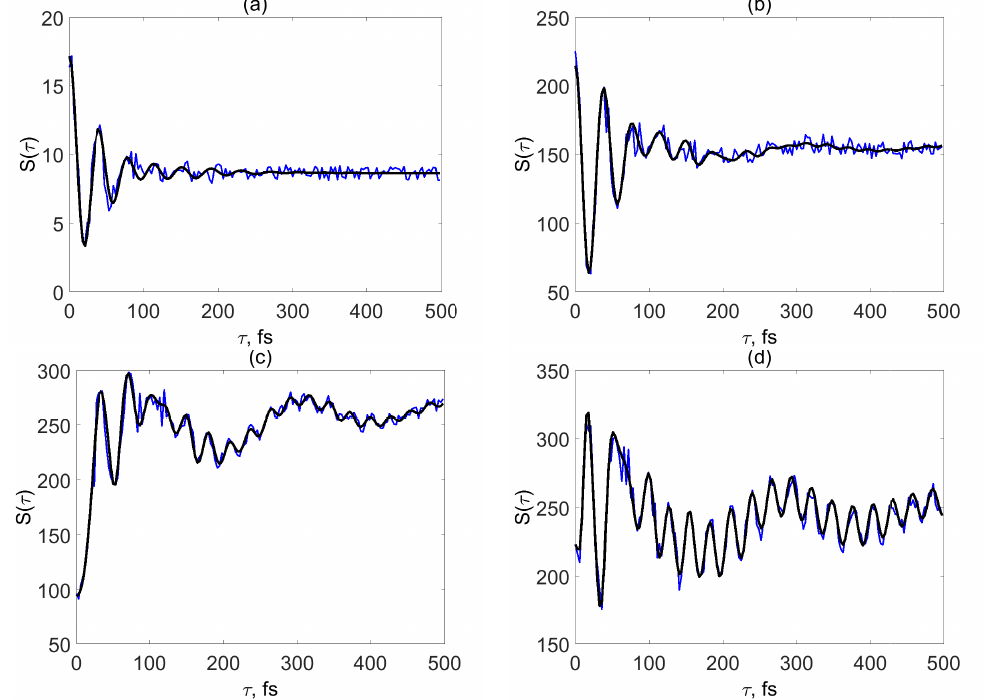
Figure 2. Model I. SM signals for different system-field couplings. η 02 = 0.01 eV ( a ), 0.05 eV ( b ), 0.11 eV ( c ), and 0.17 eV ( d ). Black lines show the single molecule (SM) signals calculated without parameter modulations. Blue lines depict the SM calculated with modulations of electronic